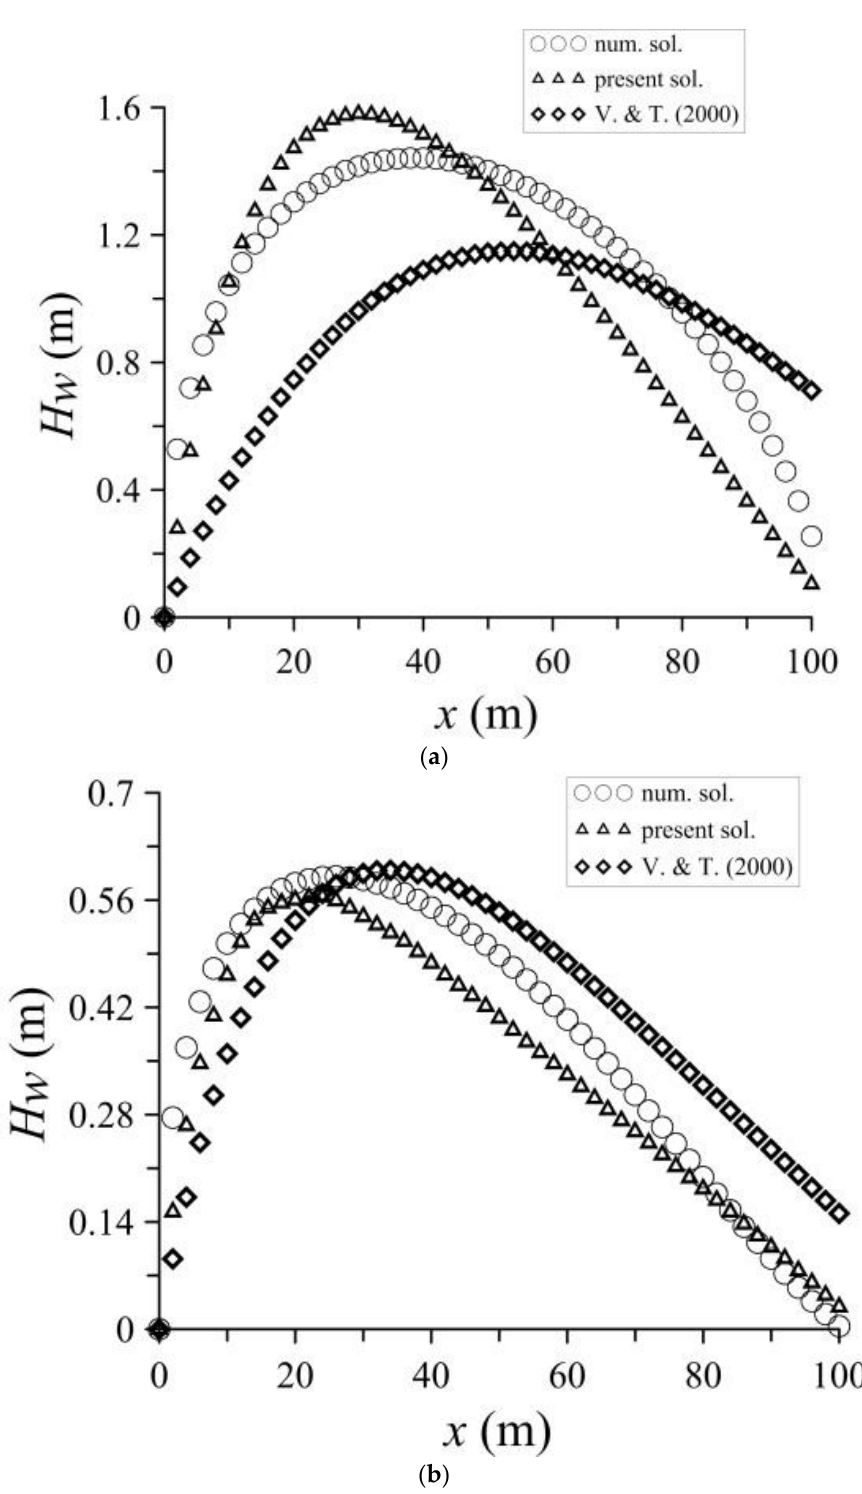
Figure 4. Spatial variation in the groundwater table under constant recharge for ( a ) 𝜃 = 2° ( b ) 𝜃 = 6° ( t = 5 days).